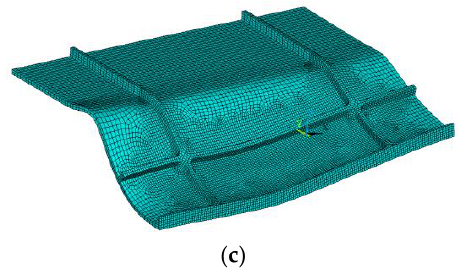
Figure 8. The multi-physics coupling model of the grid-rib panel during EMIF: ( a ) electromagnetic field model; ( b ) forming model; and ( c ) springback model.